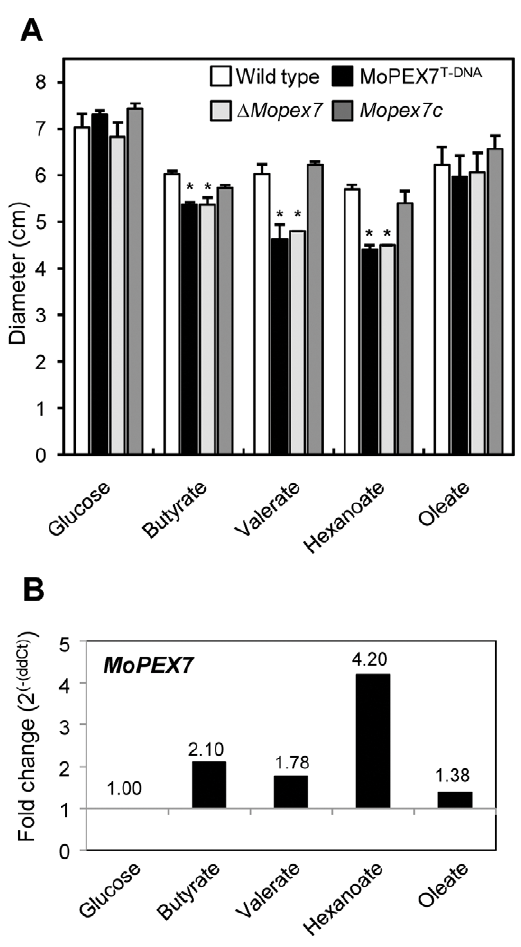
Figure 7. Utilization of fatty acids. (A) Growth on fatty acid media at 12 days post inoculation. Various carbon sources were used as sole carbon source in minimal media: 1% glucose, 2.5 mM oleate, 6 mM butyrate, 5 mM valerate and 4 mM hexanoate. (B) Expression profiling of MoPEX7 on fatty acid media.